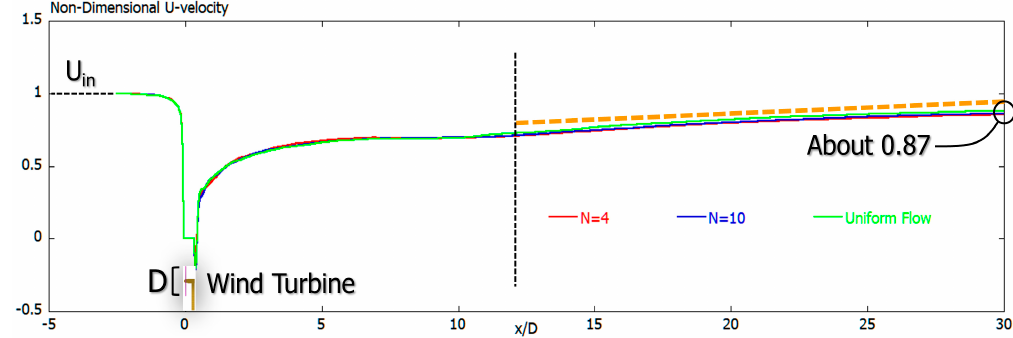
Figure 22. Comparison of time-averaged U-velocity distribution at the hub center of the wind-turbine.